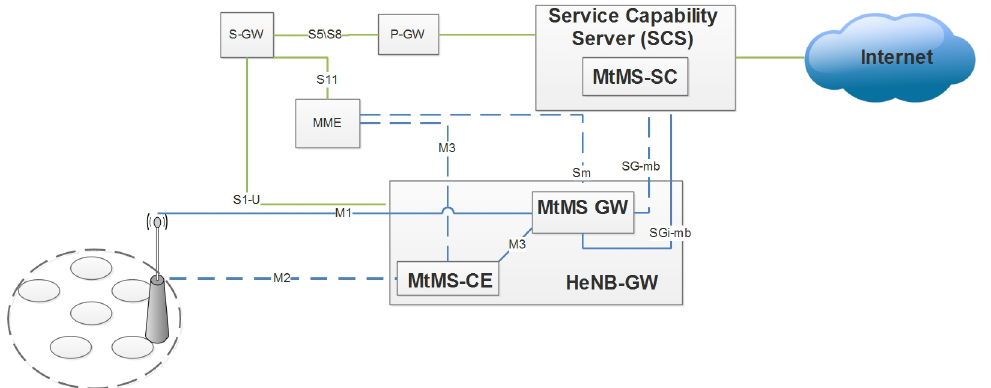
Figure 2. Interference reduction